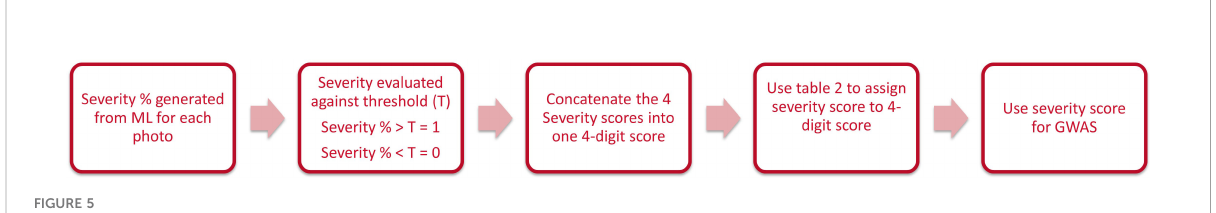
FIGURE 5 Work fl ow of generation of One-Hot Score and conversion to disease score used in GWAS